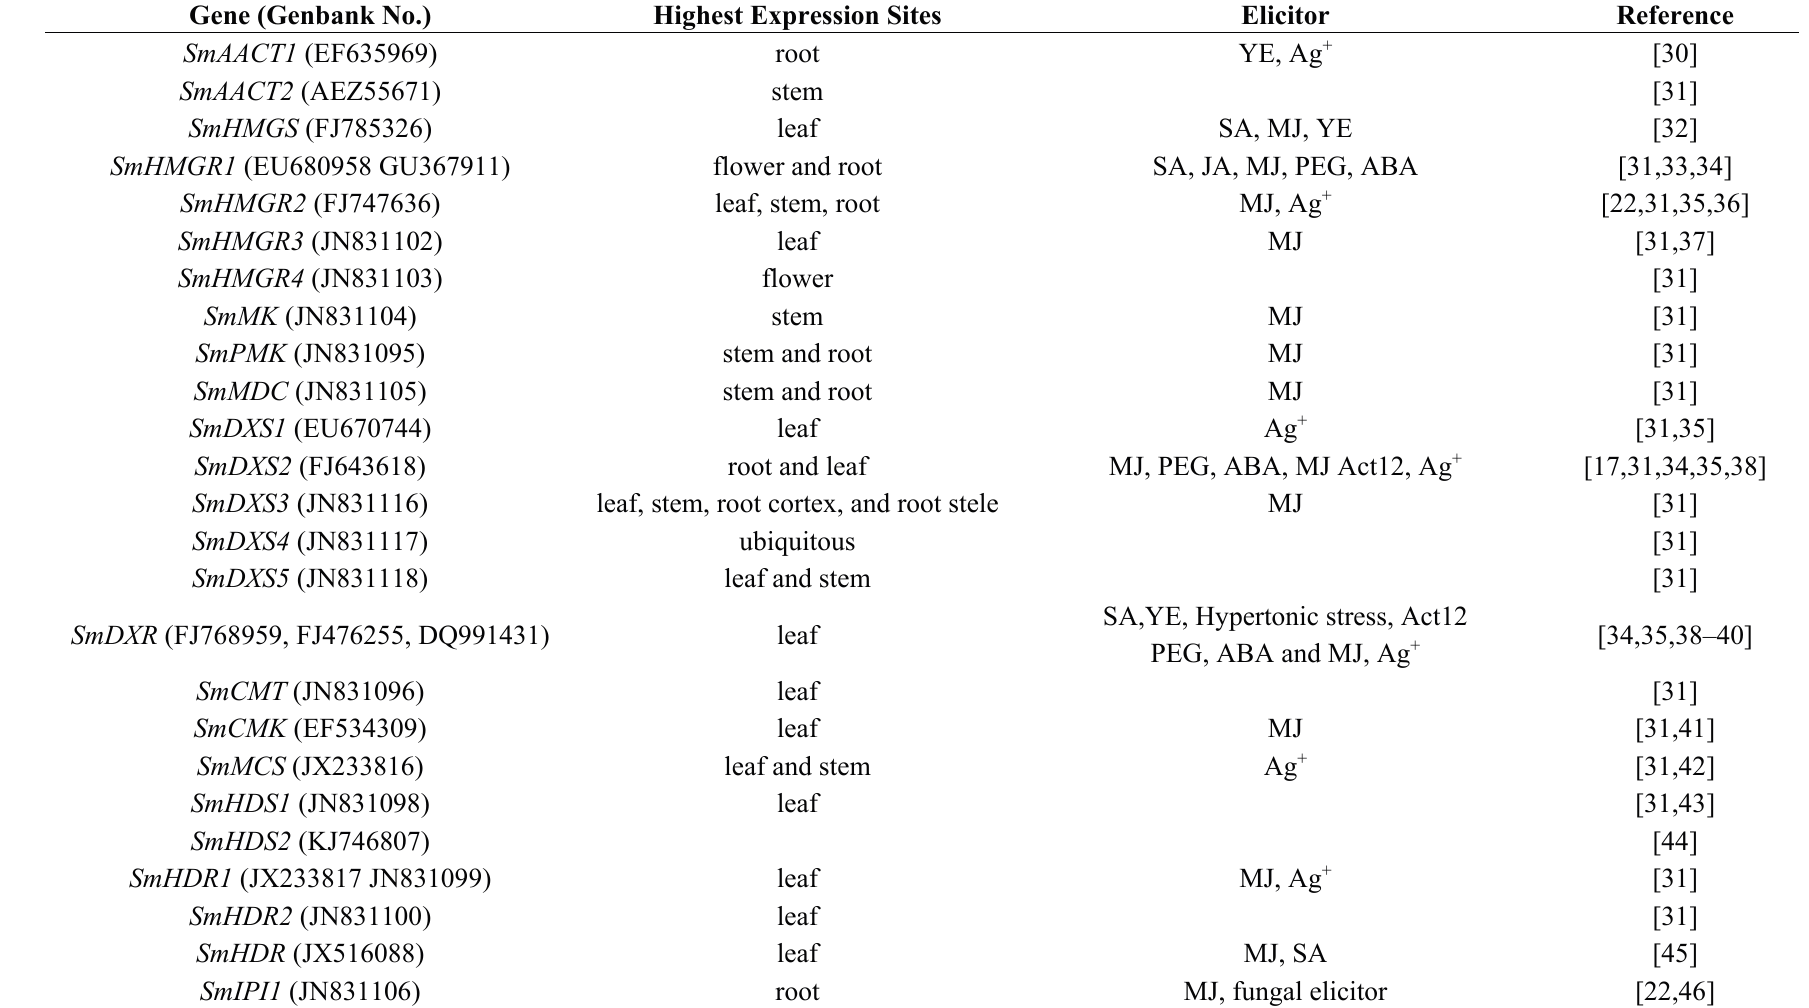
Table 1. The genes involved in isoprenoids metabolic pathway in S. miltiorrhiza